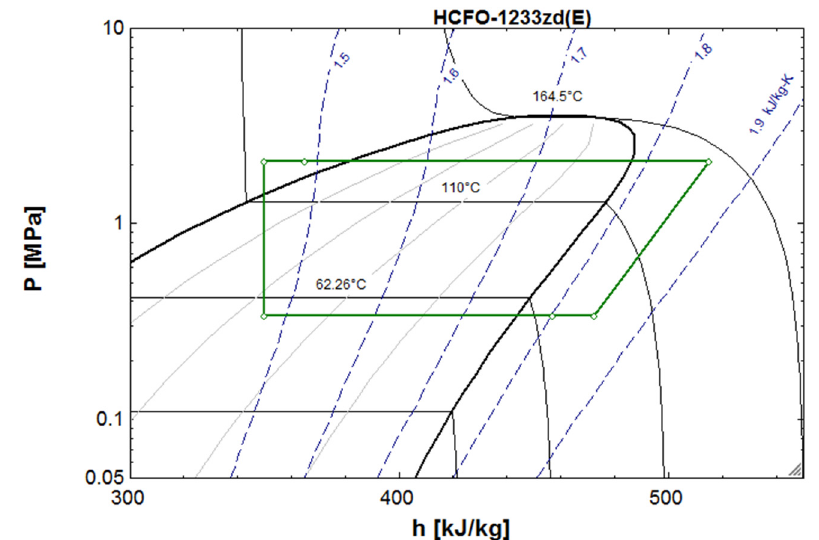
Figure 4. P-h diagram, saturation lines, and HTHP operation with HCFO-1233zd(E) generated by